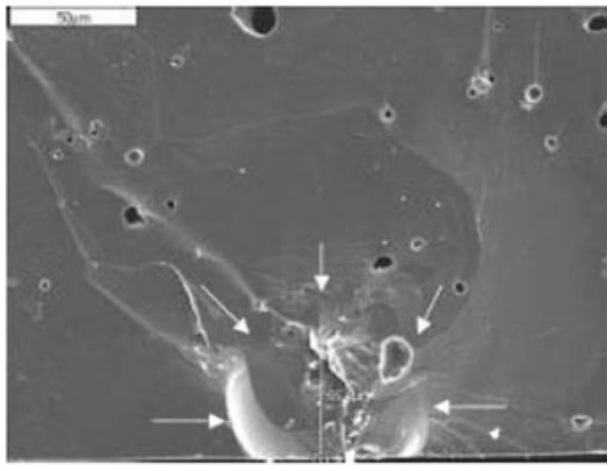
FIGURE 5- SEM micrograph of ceramic fracture surface showing a critical flaw (crack) outlined by white arrows. Fracture surface of a amorphous glass (IPS Empress2 body, Ivoclar AG, Schaan, Liechtenstein); note the tailed fracture markings (top right) pointing toward the crack origin; measured line represents the semiminor axis, a = 55 µm (500x). From Della Bona, et al . 20 , 2004.